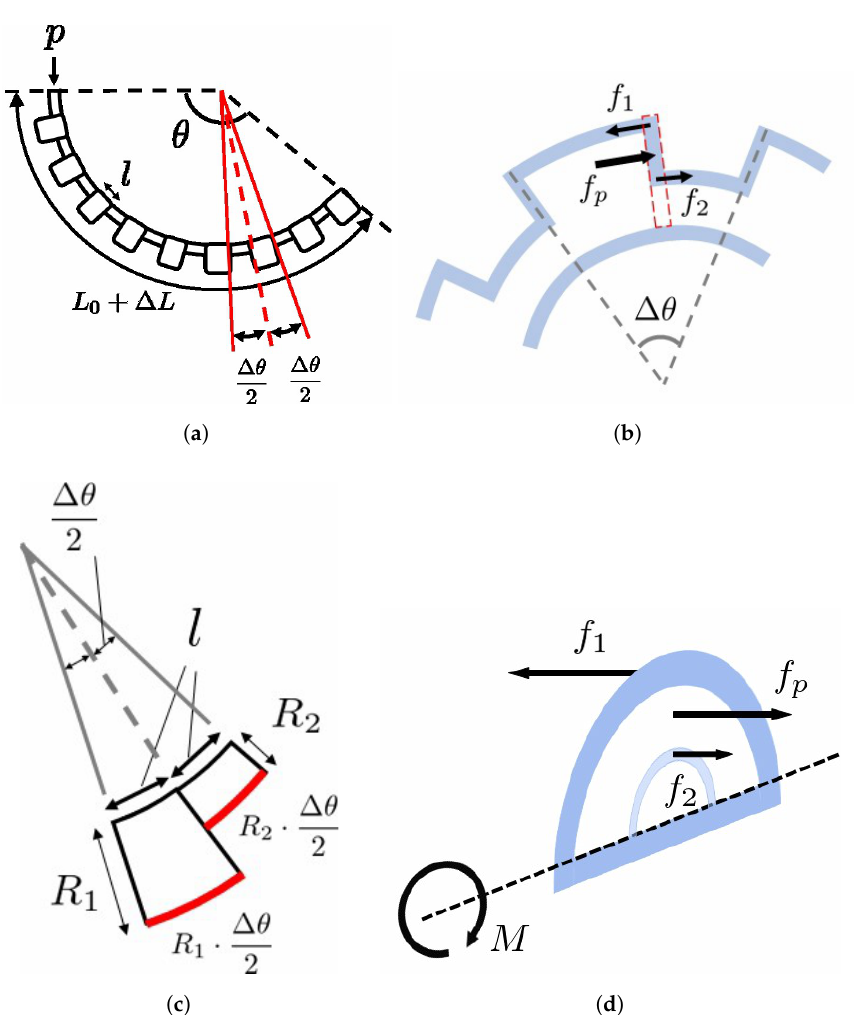
Figure 3. ( a ) The model for analysis; ( b ) Three forces working on bellow; ( c ) The strain on the outside compared with the inside; ( d ) Three moments working on joint between small channel and large